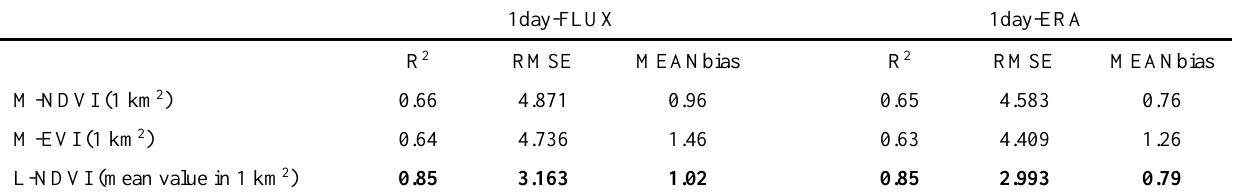
Table.1 Comparison of remote sensing based GPP estimation with in-situ measurement carbon flux data in flux tower in daily temporal scale. Here the M-NDVI and M-EVI represented for GPP estimation results from the 1-km MODIS based vegetation index